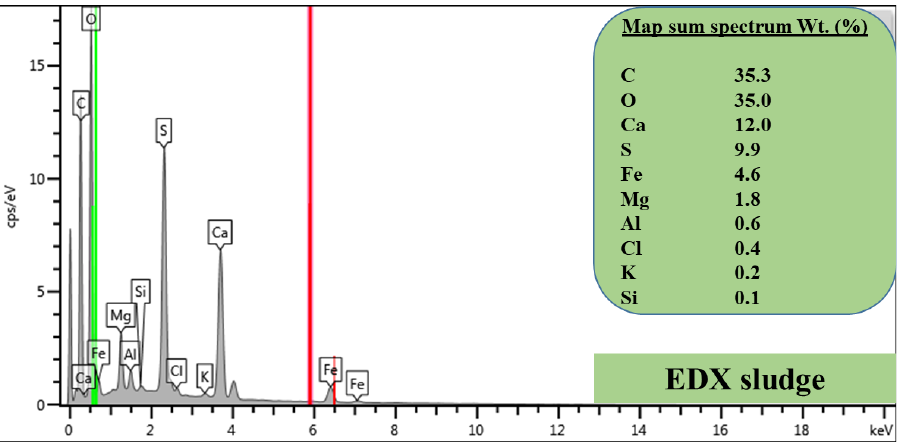
Figure 2. The elemental characteristics of the product sludge as quantified using the